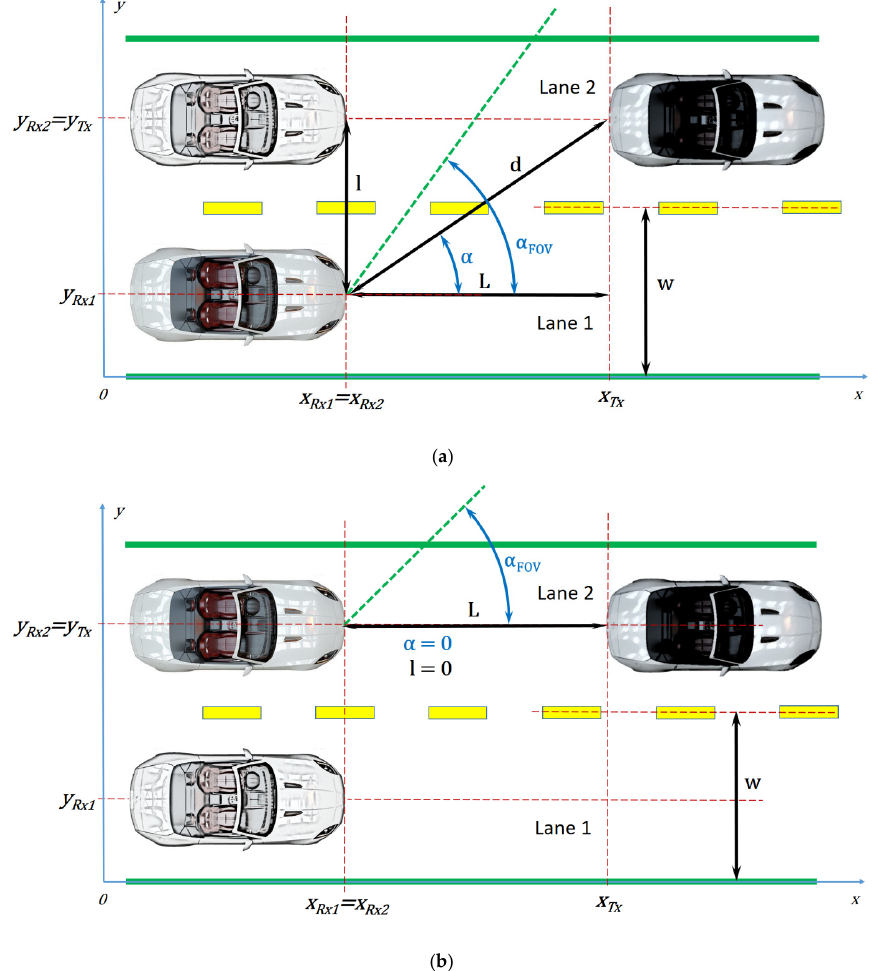
Figure 1. V2V communication scenarios: ( a ) Case one, with the communication established between two vehicles on adjacent lanes; and ( b ) case two, with the communication established between two vehicles on the same lane.